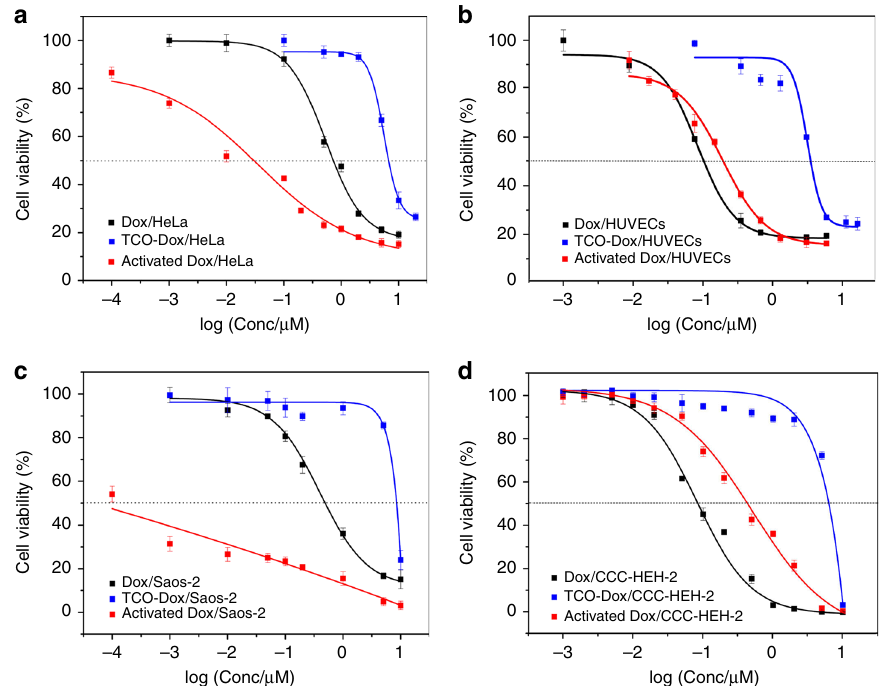
Fig. 4 Prodrug activation with high selectivity towards cancer cells. Comparison of the 72 h cytotoxicity of TCO-Dox, Dox and activated Dox against a HeLa cells, b HUVECs, c Saos-2 cells and d CCC-HEH-2 cells. Cytotoxicity pro fi les of Dox and TCO-Dox were obtained by incubating cells with different concentrations of each compound for 72 h. For the cytotoxicity pro fi le of activated Dox, cells were pre-incubated with 100 μ L of 500 μ M 2 for 6 h followed by incubation with 200 μ L of TCO-Dox at different concentrations for 72 h ( n = 6). Error bars indicate standard deviation